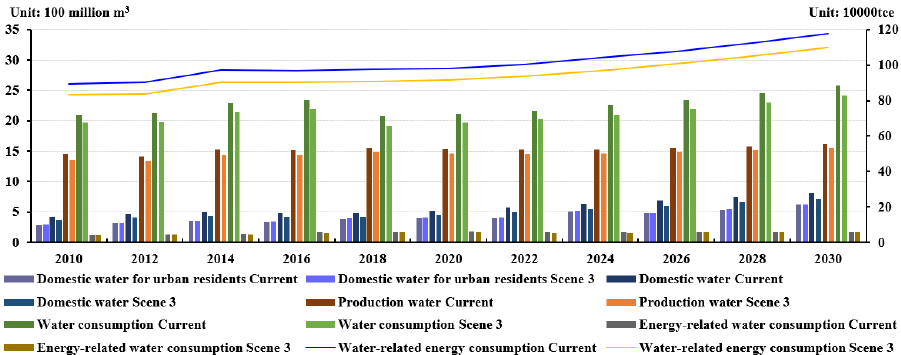
Figure 8. Simulation results of water-related indicators and energy-related indicators under CS: domestic water for urban residents, domestic water, production water, water consumption, energy-related water consumption, and water-related energy consumption.